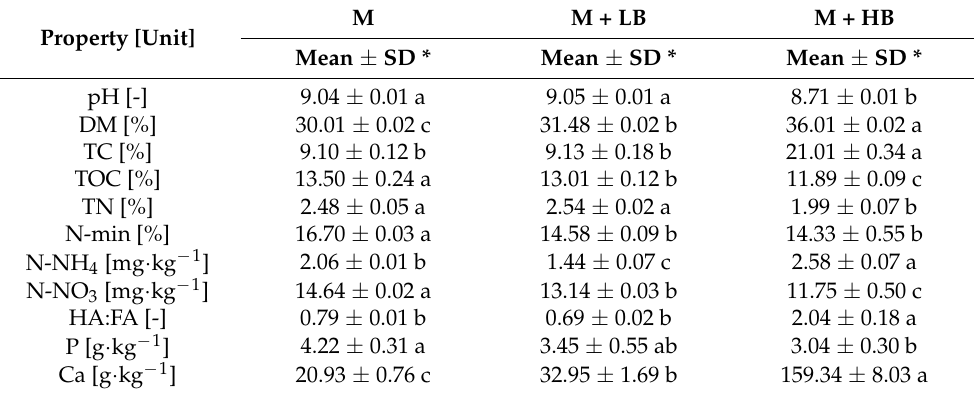
Table 3. Properties of matured manures—pH, dry matter (DM), total carbon (TC), total organic carbon (TOC), total nitrogen (TN), mineral nitrogen (N-min), ammonium nitrogen (N-NH 4 ), nitrogen in nitrate form (N-NO 3 ), humic acid:fulvic acid ratio (HA:FA), available phosphorus (P), available calcium (Ca). Mean values calculated as average from independent replicates ( n = 4) ± SD (standard deviation). * Different letters express the statistical differences at the significance level p ≤ 0.05.